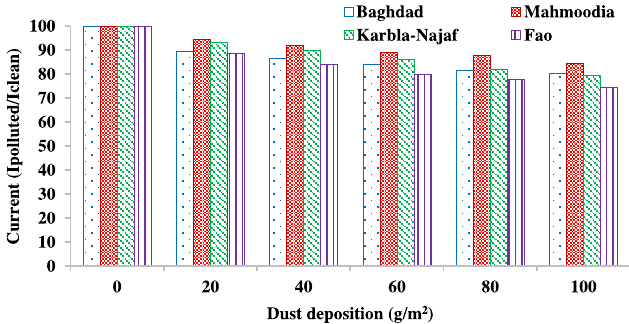
Fig. 3. Dust accumulation effect on I polluted / I clean